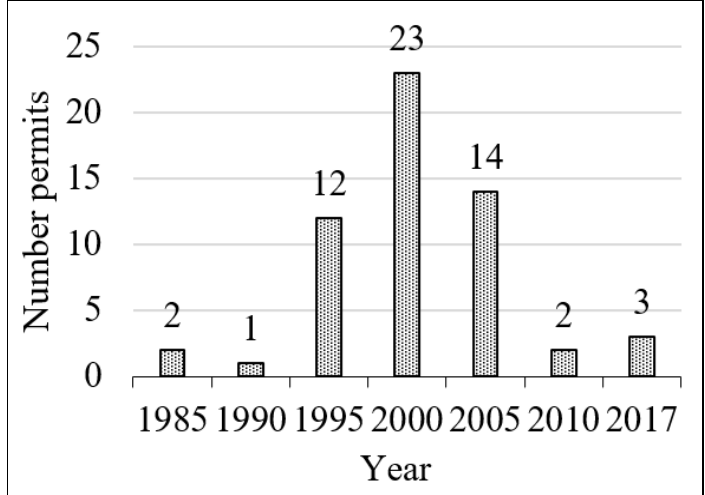
Figure 5. Number of new permits issued between each 5-year sequence.